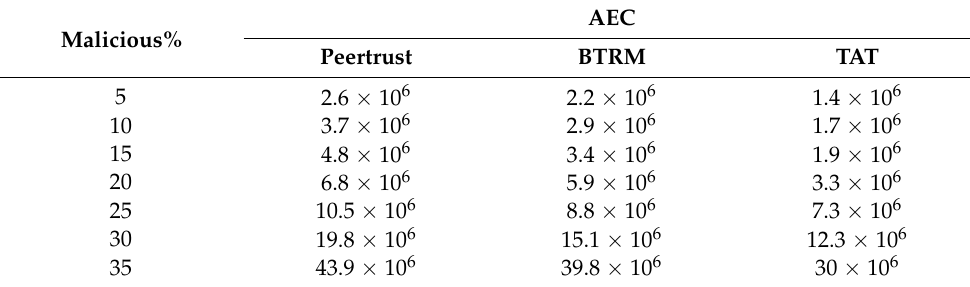
Table 3. Total AEC ( µ J) in the network for TAT, PeerTrust, and BTRM